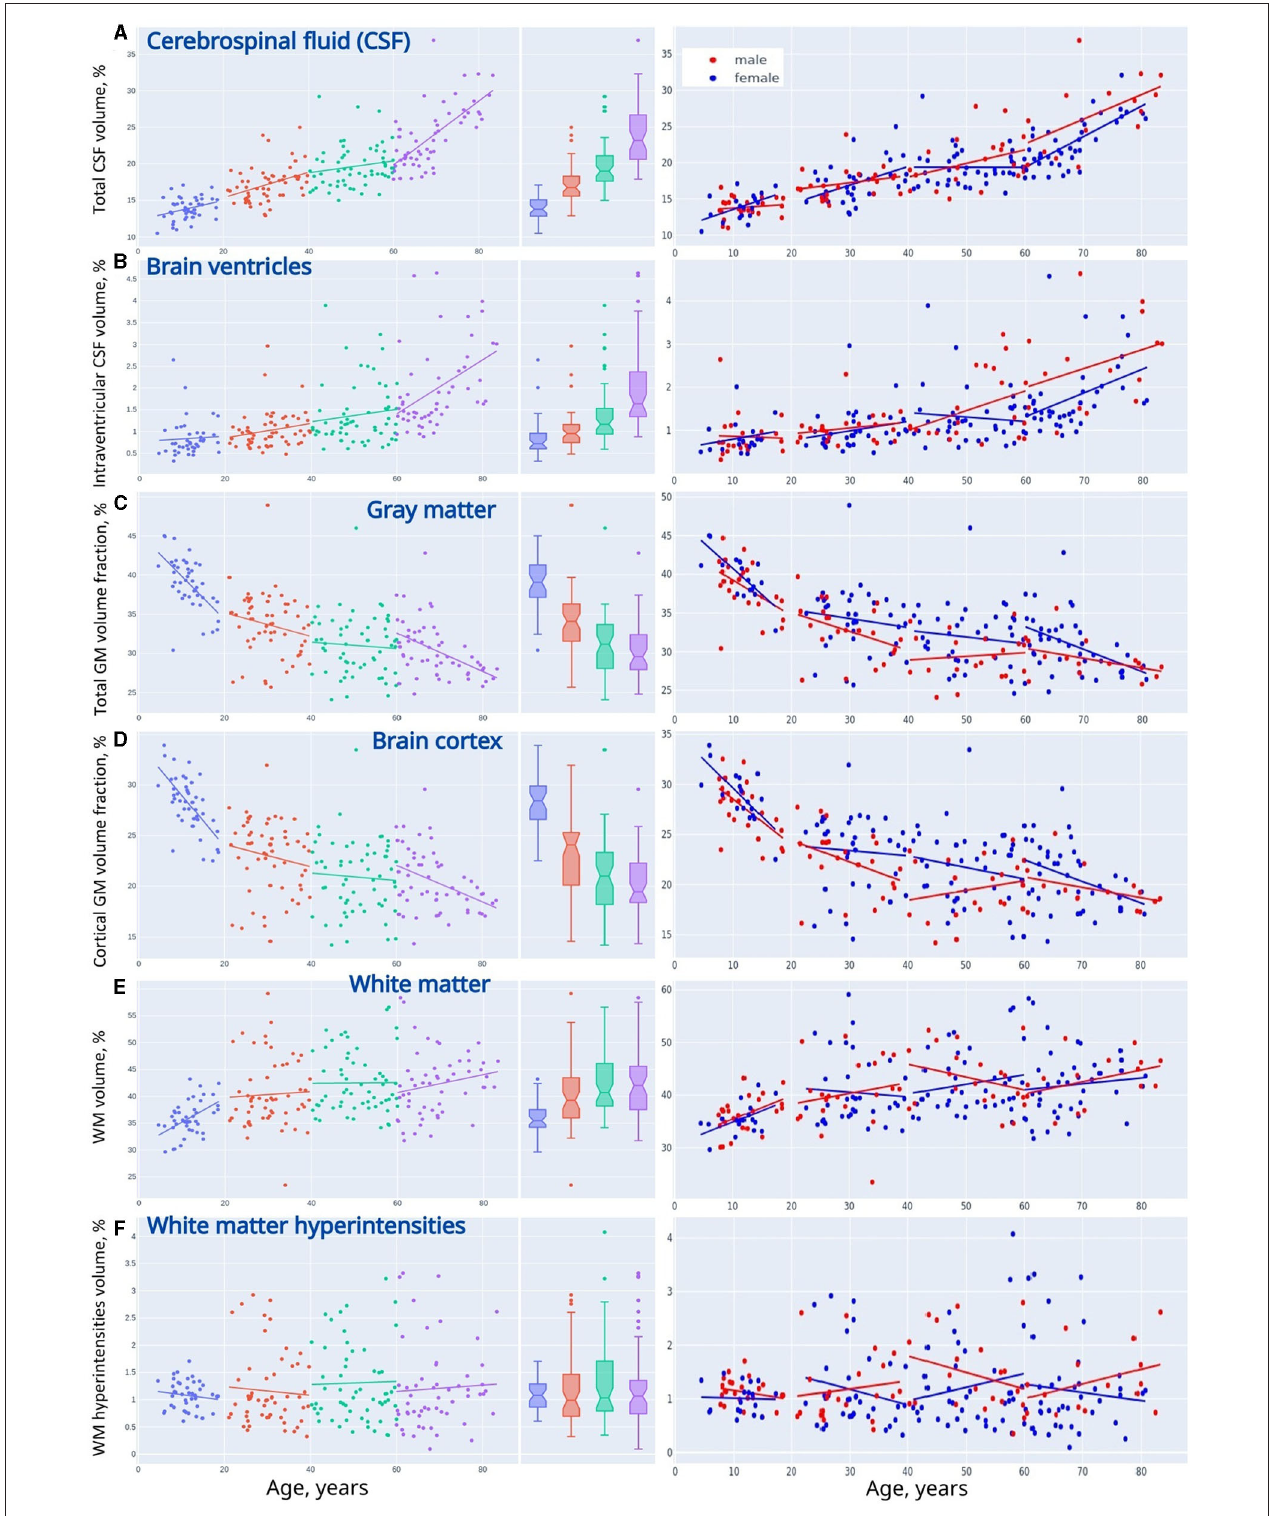
FIGURE 3 | Linear trendlines presenting changes in VBM across life periods (adolescents, young adults, midlife adults, and older adults). (A) Cerebrospinal fluid, (B) brain ventricles, (C) gray matter, (D) brain cortex, (E) white matter, and (F) white matter hyperintensities.